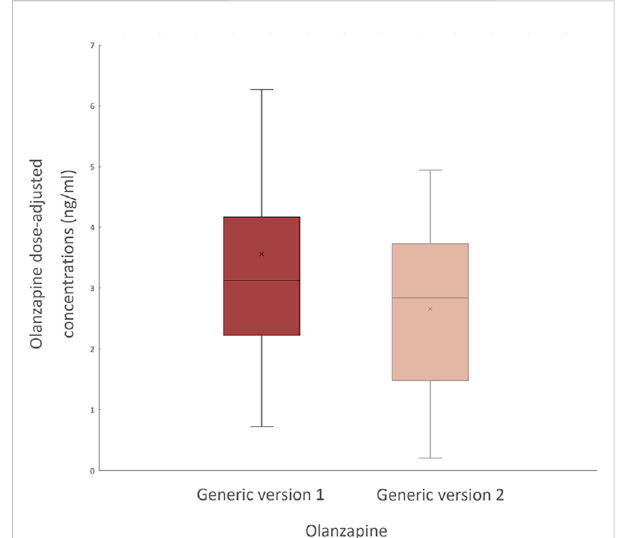
FIGURE 1 Steady-state olanzapine dose-adjusted concentrations before (generic version 1, the original generic olanzapine) and after (generic version 2, the bid-winning olanzapine) drug switch.